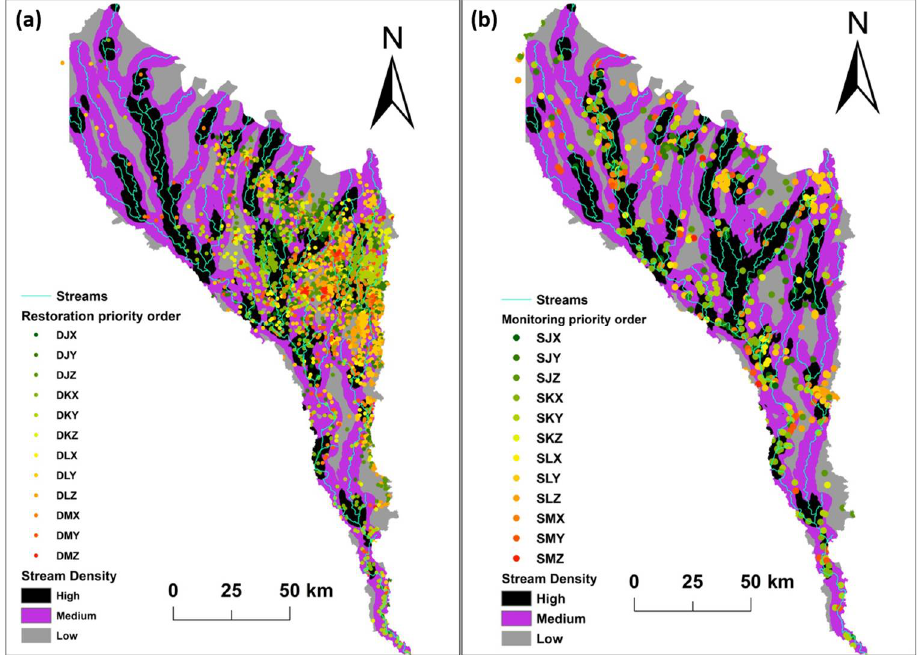
Figure 5. Distribution of wetlands based on the priority lists in relation to streams and stream density for ( a ) restoration and ( b ) monitoring lists. Most of the stable wetlands are in the proximity to streams whereas most of the degrading wetlands are in interfluves.